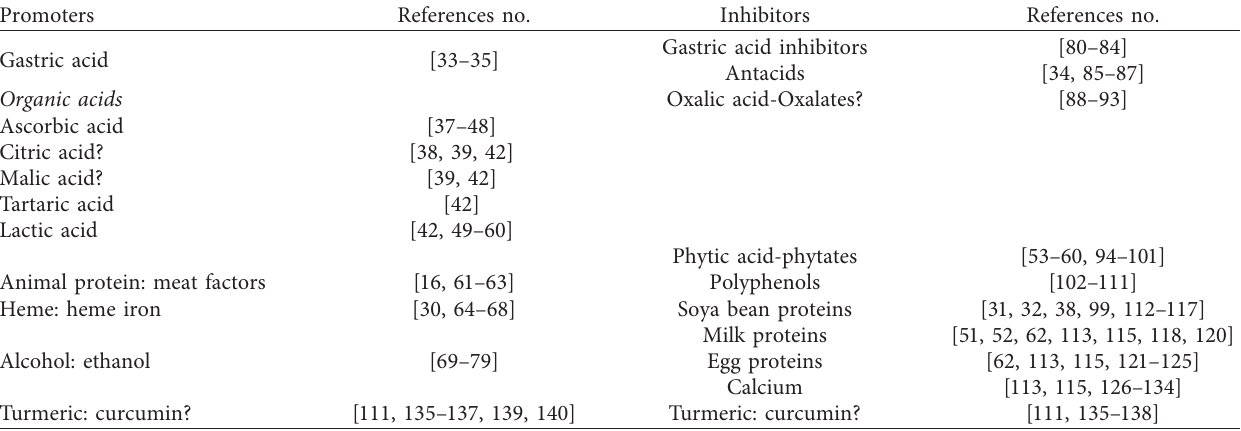
Table 1: Promoters and inhibitors of iron